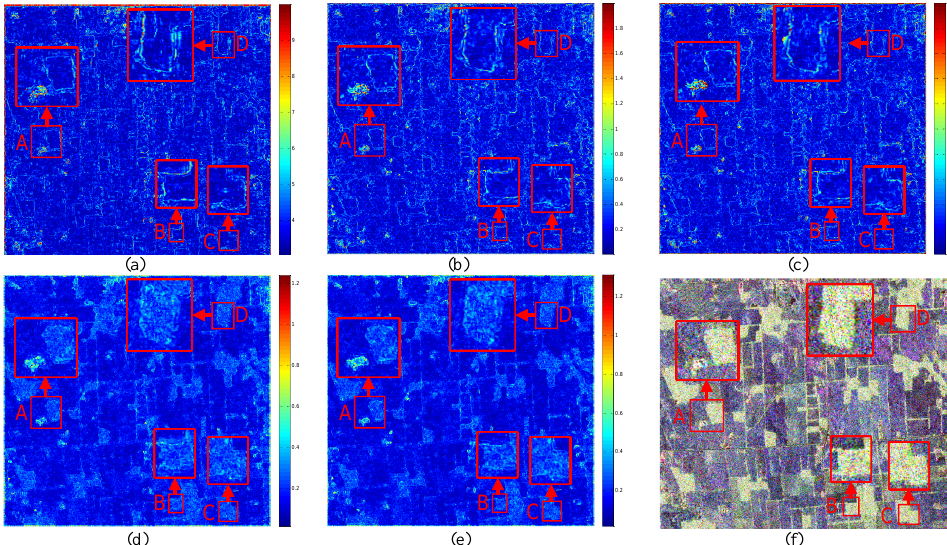
Figure 23. Final distance between a pixel and its clustering center based on the RADARSAT-2 data set. ( a ) POL-HLT. ( b ) HAWS. ( c ) The proposed HCI based on the RWD. ( d ) HAGS. ( e ) The proposed HCI based on the GD. ( f ) Pauli-RGB